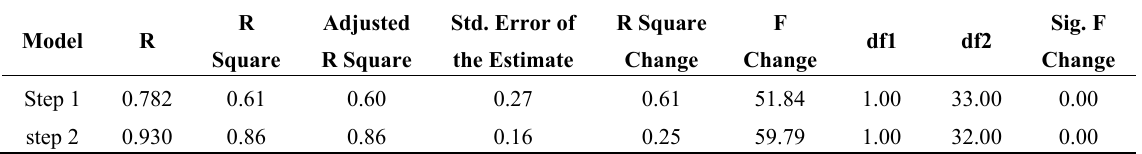
Table 10. Stepwise model summary statistics.